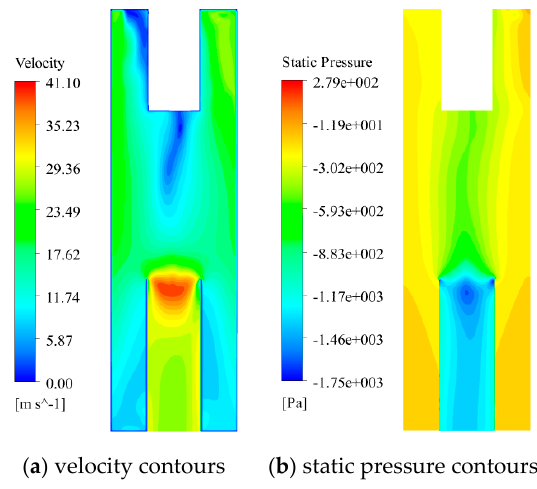
Figure 6. Flow field distribution at z = 1.5 m: ( a ) velocity contours, ( b ) static pressure contours.